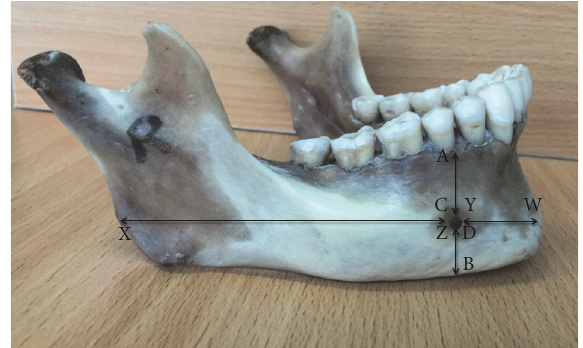
Figure 2: Mandibular anthropometrics from defined landmarks. AB: distance from alveolar crest to lower border of mandible, AC: distance from alveolar crest to upper margin of mental foramen (MF), BD: distance from lower border of mandible to lower margin of MF, WX: distance from symphysis menti to posterior border of ramus of mandible, WY: distance from symphysis menti to medial margin of MF (anterior chord), and XZ: distance from posterior border of ramus of mandible to lateral margin of MF (posterior